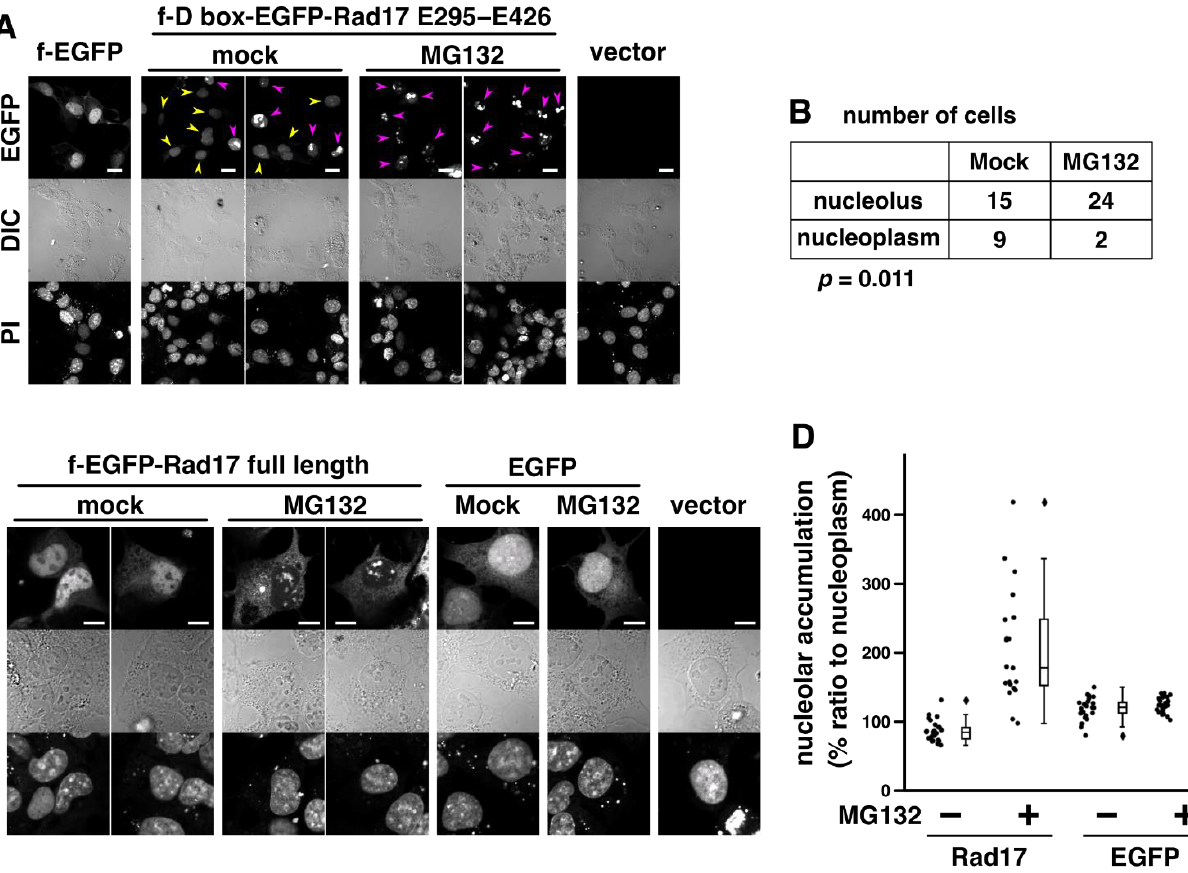
Figure 3. Inhibition of proteasomal degradation promotes nucleolar translocation of Rad17. ( A,C ) COS-1 cells were transfected with flag-D box (Rad17 H36‒G66) -EGFP-Rad17 E295‒E426 ( A ) or flag-EGFP-Rad17 full-length ( C ) and fixed 48 h after transfection. The cells were exposed to 20 μ M MG132 for 7 h before fixation. Arrowheads indicate cells in which the EGFP signal was localized (magenta) or not localized (yellow) in the nucleolus. Scale bars are 2 0 μm ( A ) and 10 μm ( C ). ( B ) The signal intensity of flag-D box-EGFP-Rad17 E295‒E426 was quantitated in the nucleolus and the nucleoplasm. The ratio of nucleolus to nucleoplasm was calculated, and cells with ratio higher than three were counted as nucleolar localization. Table shows the number of cells with nucleolar and nucleoplasmic localization of flag-D box-EGFP-Rad17 E29 5‒E426 in two independent experiments. The p -value was calculated with the chi-square test. ( D ) The signal intensity of flag-EGFP-Rad17 full-length in the nucleolus and the nucleoplasm was quantitated. The ratio of nucleolus to nucleo- plasm was calculated. The graph shows representative results of two independent experiments. Rad17 mock- and MG132-exposed groups showed significant difference with p- values of less than 0.001 in the Welch t-test. DIC, differential contrast. PI, propidium iodide. 2.5. UV Irradiation Promotes the Nucleolar Localization of Rad17 A previous report has demonstrated that Rad9B, a paralog of canonical Rad9 protein, translocates to the nucleolus upon UV irradiation [13]. Thus, we examined the effect of UV irradiation on the subnuclear localization of Rad17. The flag-EGFP-Rad17 full-length protein accumulated in the nucleolus of a subset of UV-irradiated cells (Figure 4A,B). Rad17 formed discrete foci in the nucleolus or distributed within the nucleolus. Because UV irradiation inhibits general transcription in the nucleus, one possible explanation may be that UV irradiation induces the nucleoplasmic depletion of Rad17 to result in the nu- cleolar accumulation. However, the inhibition of proteasomal degradation promoted the nucleolar accumulation of Rad17 (Figure 3), suggesting that the degradation or repression of Rad17 does not promote the nucleolar accumulation. These results indicate that UV irradiation induces the nucleolar translocation of Rad17.